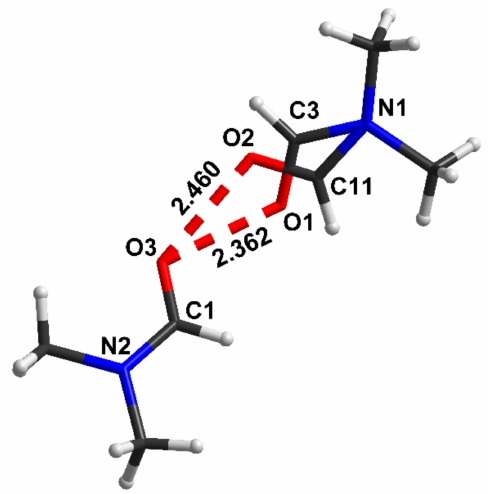
Figure 20. The structure of [(DMF) 2 H. The C–O bond lengths are 1.272 Å (at O ··· O = 2.37 Å) and 1.266 Å (at O ··· O = 2.474